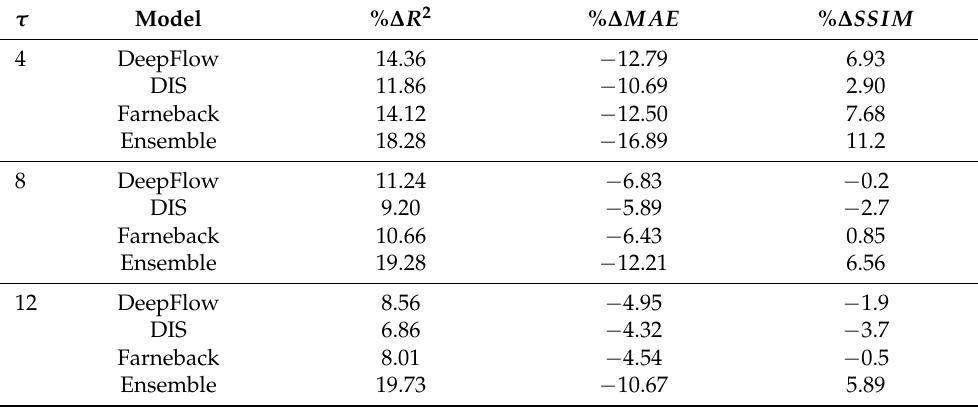
Table 1. Average percentage differences in accuracy metrics of optical flow predictions against the persistence baseline, grouped by lead time ( τ ).